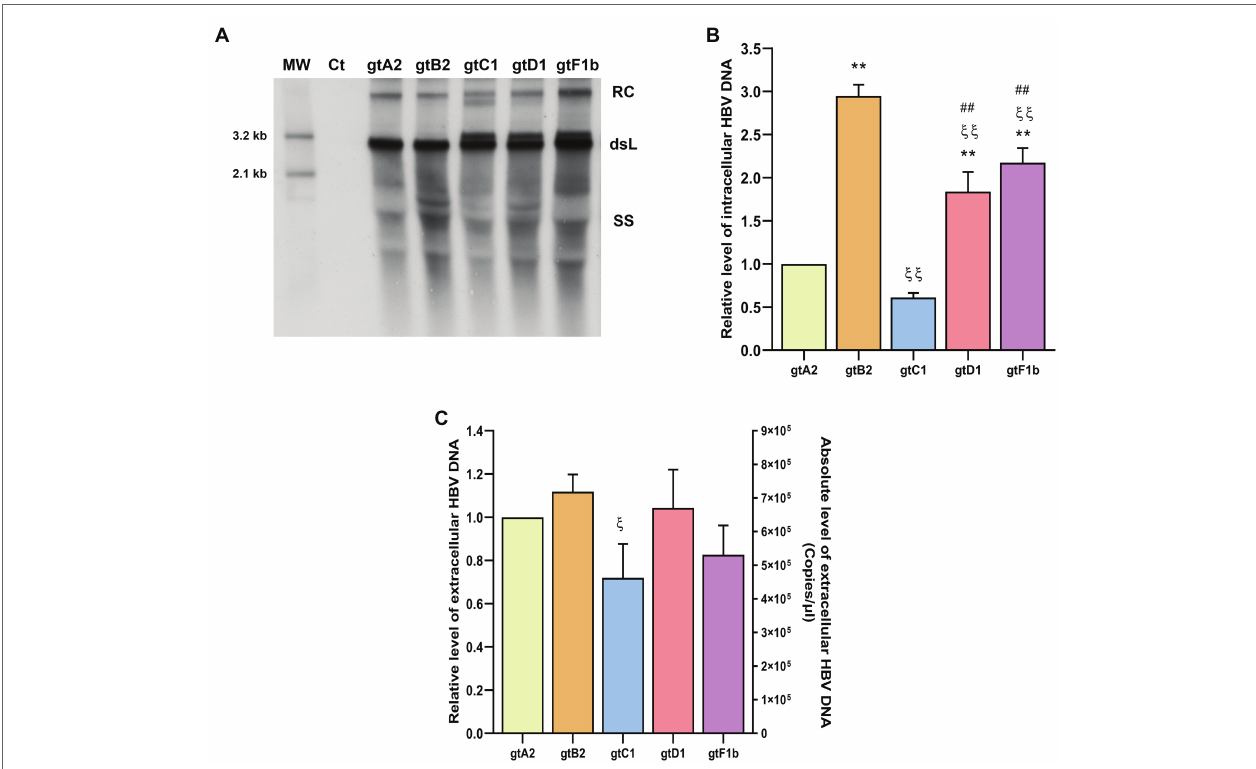
FIGURE 3 | Analysis of HBV DNA levels among genotypes. HuH-7 cells were transfected with linear full-length HBV genomes of genotypes A2, B2, C1, D1, and F1b. Three days post-transfection, cells and culture supernatants were harvested. (A) HBV DNA replicative intermediates were assessed by Southern blot analysis. Ct: cell transfected with pUC19 empty vector (control); RC: HBV relaxed circular DNA; dsL: HBV double-stranded linear DNA; SS: HBV single-stranded DNA. (B) Relative intensity of the SS band was quantified using ImageJ software. The band corresponding to the dsL HBV DNA was not included in the quantitative analysis because this DNA may be partially derived from transfected input DNA. (C) HBV extracellular DNA levels were determined by qPCR. Shown values represent the mean ± standard deviation of three independent experiments. *: difference in relation to gtA2, ξ : difference in relation to gtB2, #: difference in relation to gtC1 and &: difference in relation to gtD1. One symbol: p < 0.005 and two symbols: p < 0.0001.